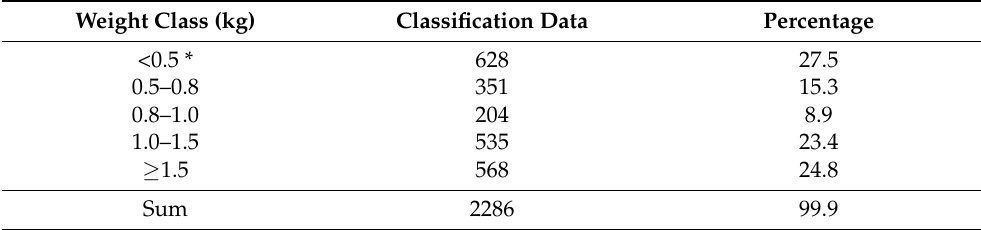
Table 3. Distribution of Hokkaido fruits within the weight classes for food